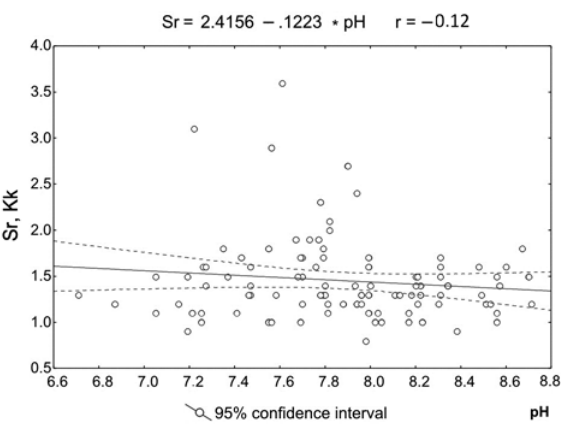
Fig. 6. Correlation ( r ) between concentration coeficient of stroncium (Sr) and topsoil pH value in eldership of Šnipiškės of the city Vilnius